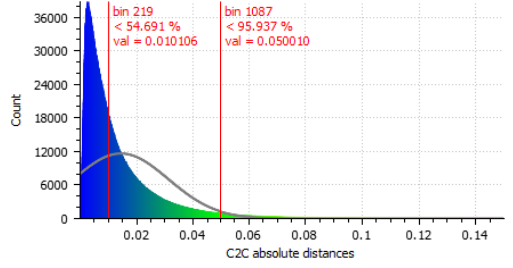
Figure 13. Histogram of C2C distances for the Photoscan controlled model with 150 photos. 54.7% of points are <1cm and 95.9% are